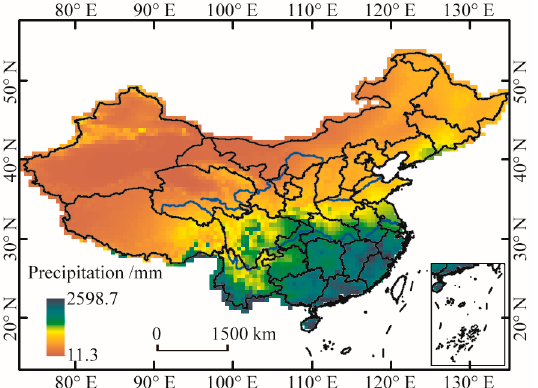
Figure 1. Spatial pattern of average annual precipitation for the period 1961–2020.